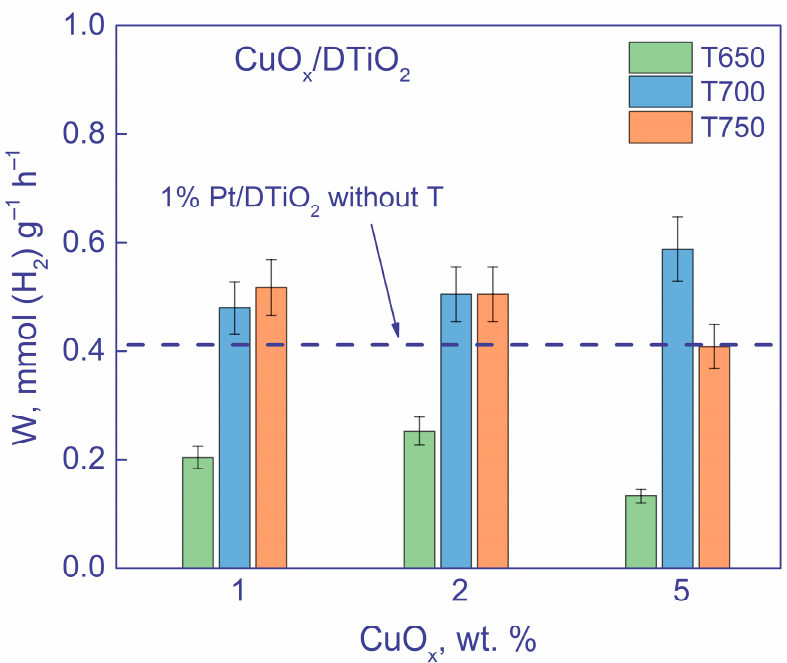
Figure 9. Rates of H 2 evolution over CuO x /DTiO 2 . Conditions: m(cat.) = 50 mg, V = 100 mL, C 0 (glycerol) = 0.38 M, λ = 427 nm. Table 5. Activity of synthesized